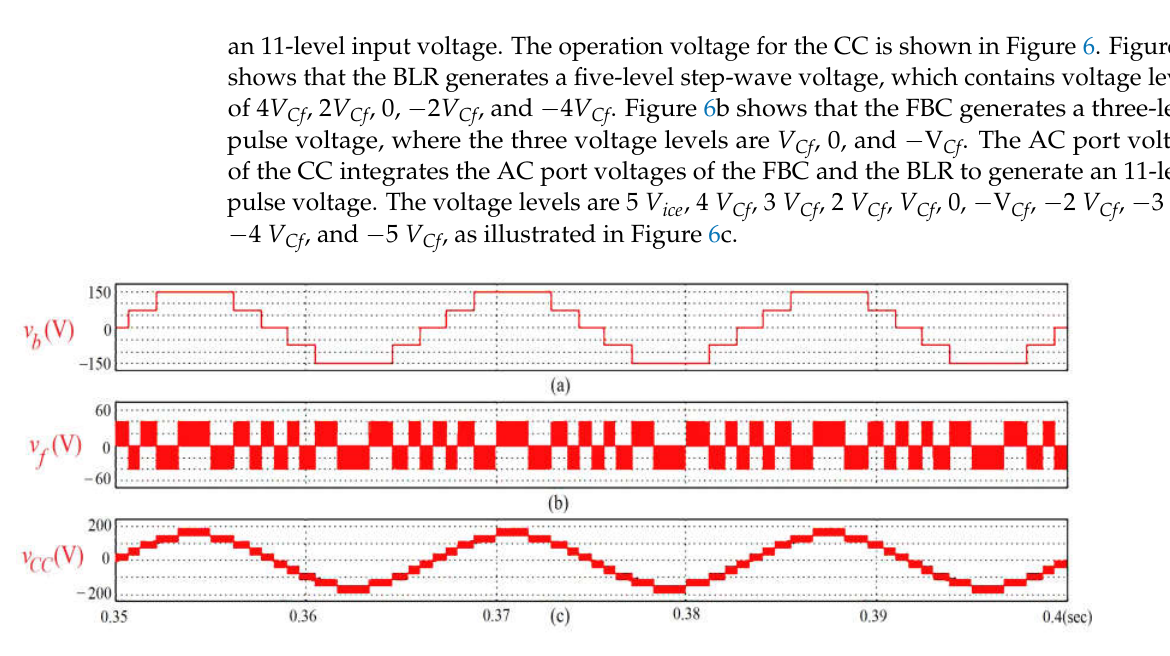
Figure 6. Simulation results on AC port voltages: ( a ) BLR; ( b ) FBC; ( c ) CC.